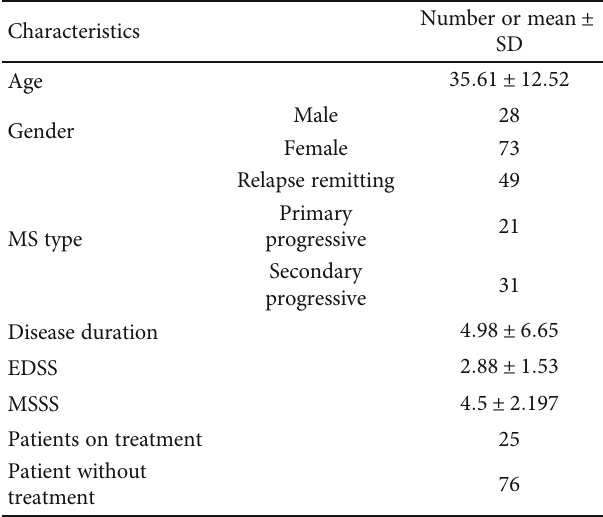
Table 2: Demographic and clinical details of MS